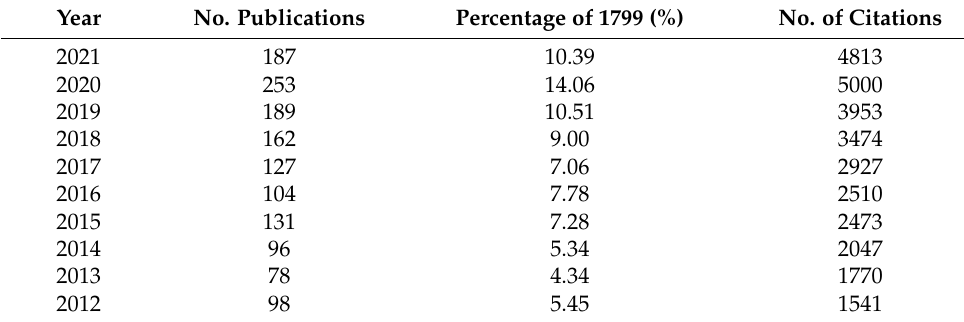
Table 1. Number of publications and citations of last 10